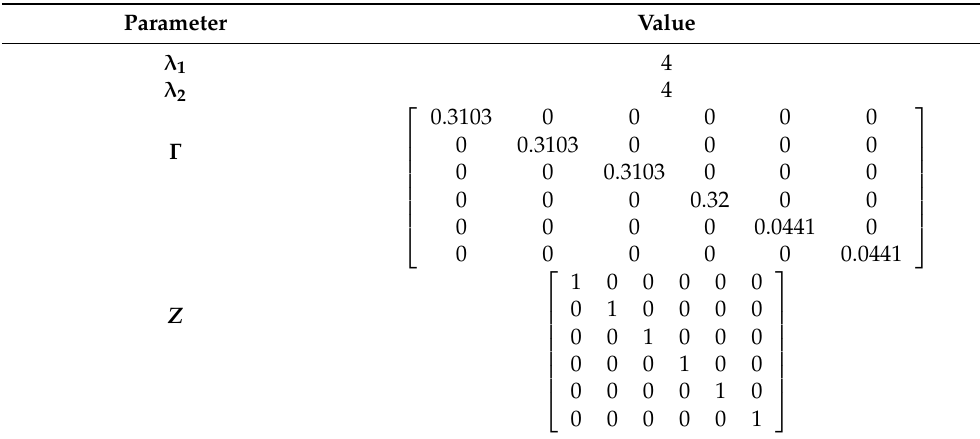
Table 5. The control parameters of the nonlinear H ∞ control law.